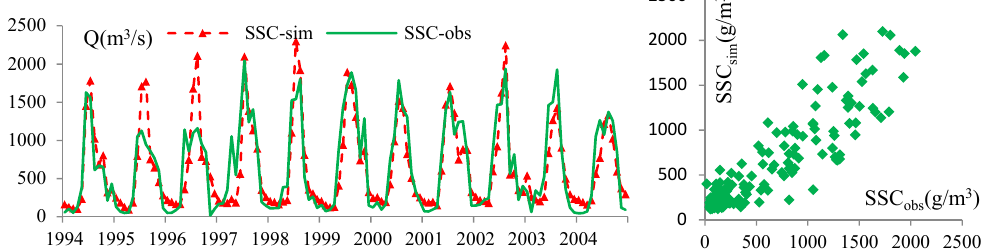
Figure 6. Comparison of observed and simulated monthly SSC at the Laichau station. Table 3. Performance of new sediment rating curve for the Laichau station.